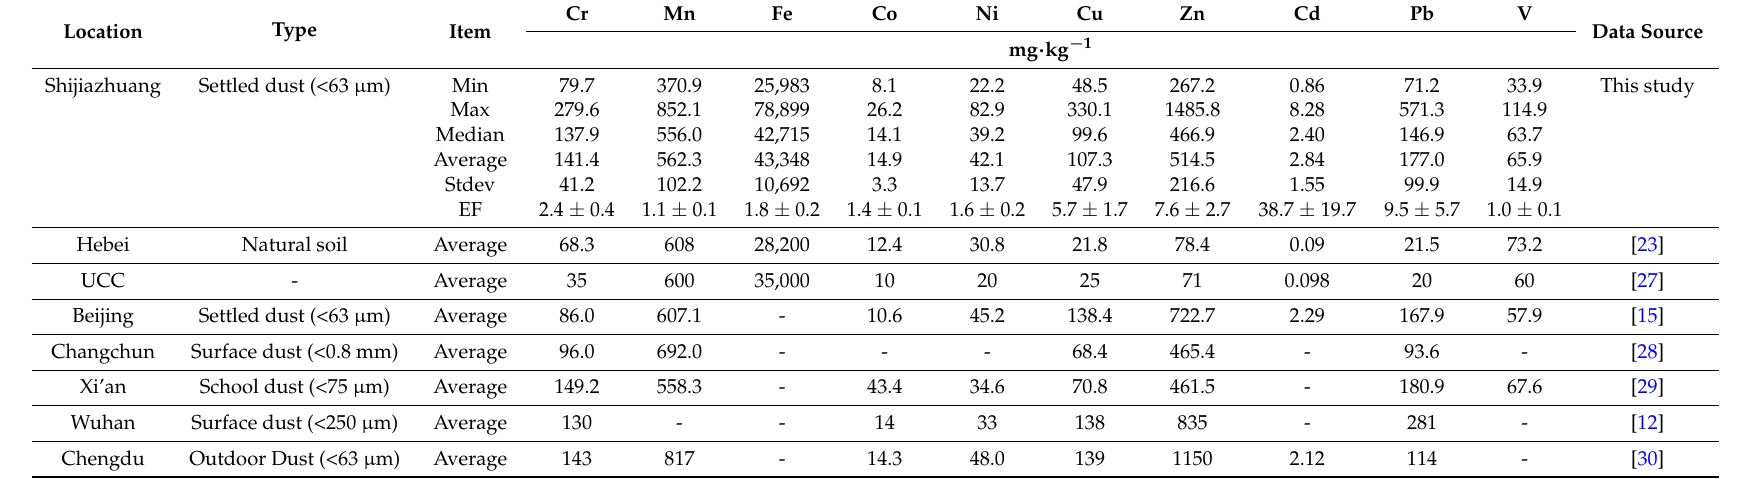
Table 1. Statistical results (mg · kg − 1 ) and enrichment factor (EF) values for heavy metal concentrations in the <63 µ m fractions of the 43 settled dust samples from the Shijiazhuang main urban area. Besides, average concentrations of heavy metals in the local natural soil, the Upper Continental Crust (UCC), and dust from other typical cities in China are also